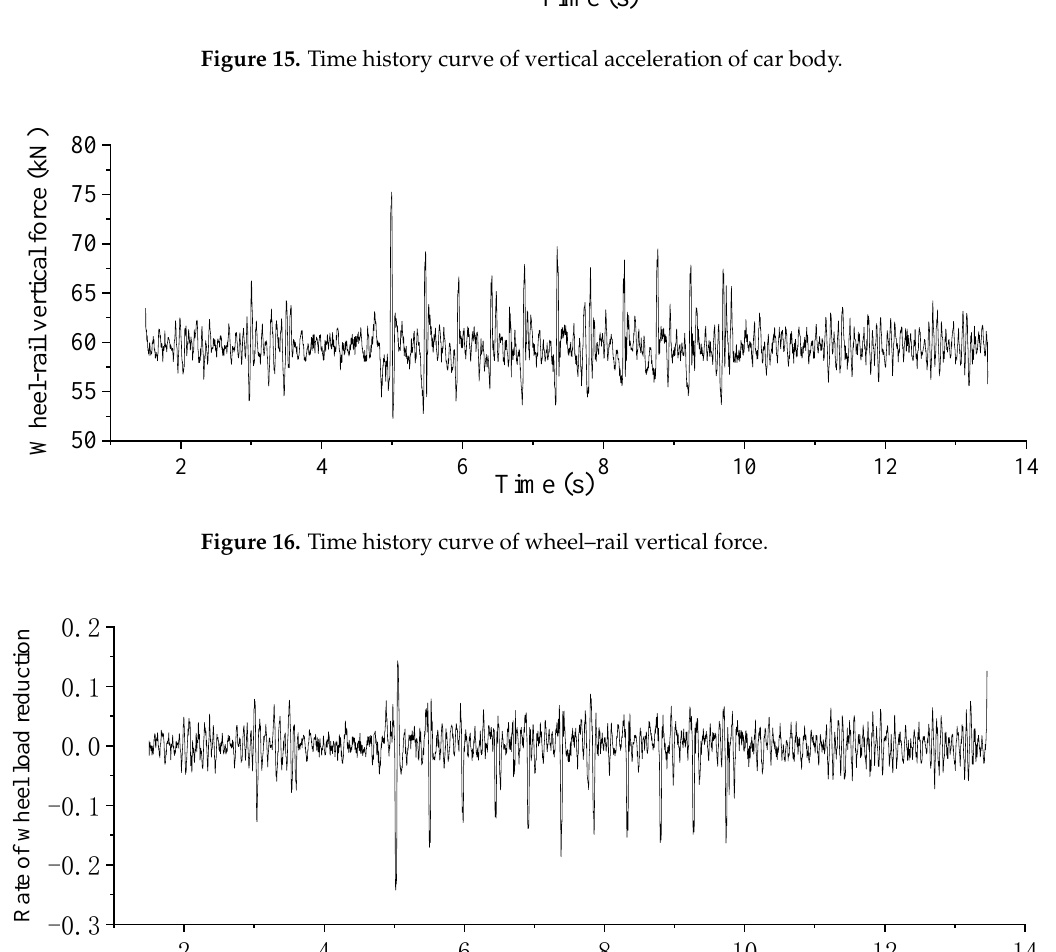
Figure 18. Vertical acceleration of car body.